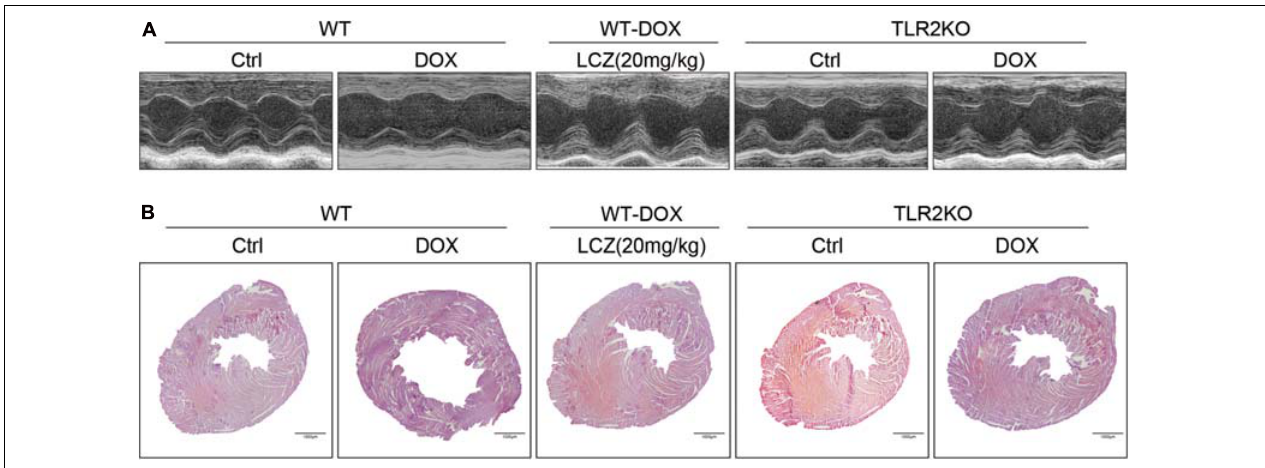
FIGURE 1 | LCZ696 treatment and TLR2 deficiency attenuated doxorubicin-challenged systolic dysfunction. (A) Representative echocardiogram images of each group. (B) Representative H&E staining of heart tissues showing the effect of LCZ696 and TLR2 deficiency on doxorubicin-induced dilated cardiomyopathy in mice [original magnification 1 ×